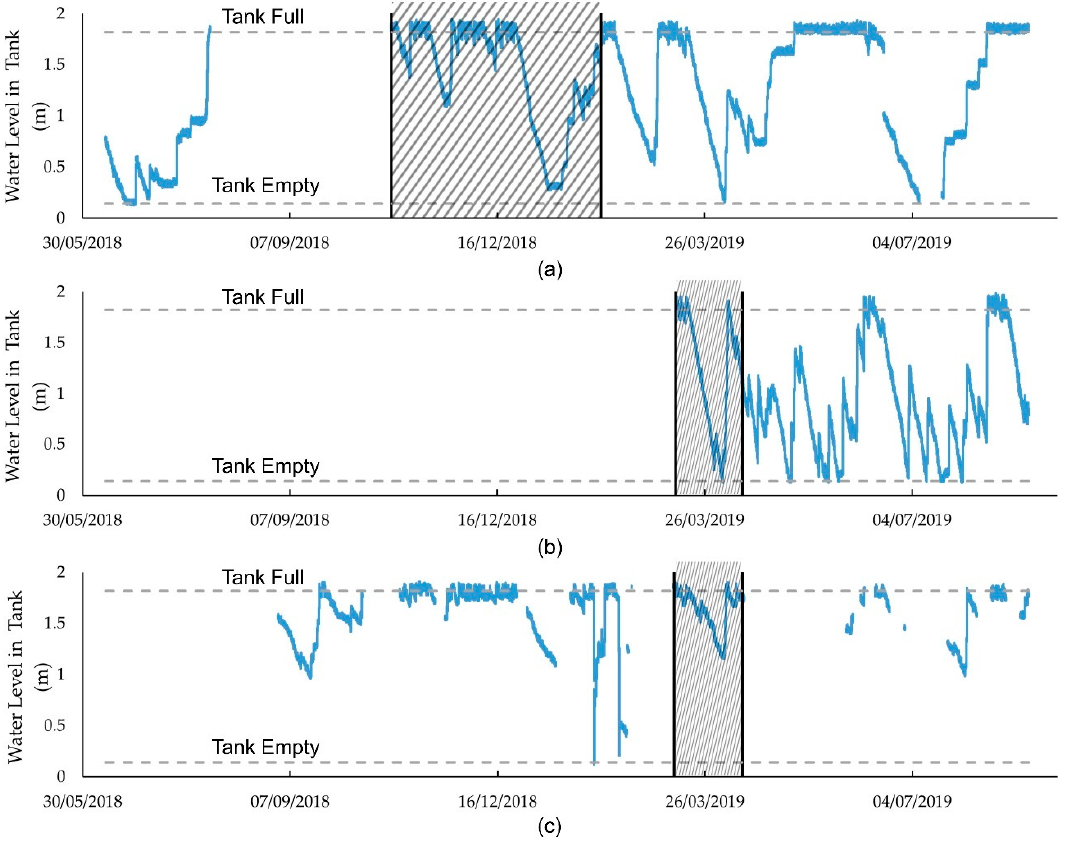
Figure 2. Water level in RWH systems: ( a ) House A, ( b ) House B and ( c ) House C.